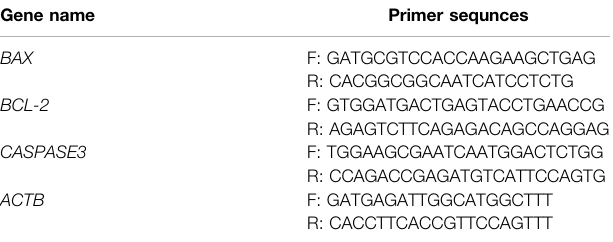
TABLE 1 | Primer sequences of qPCR.